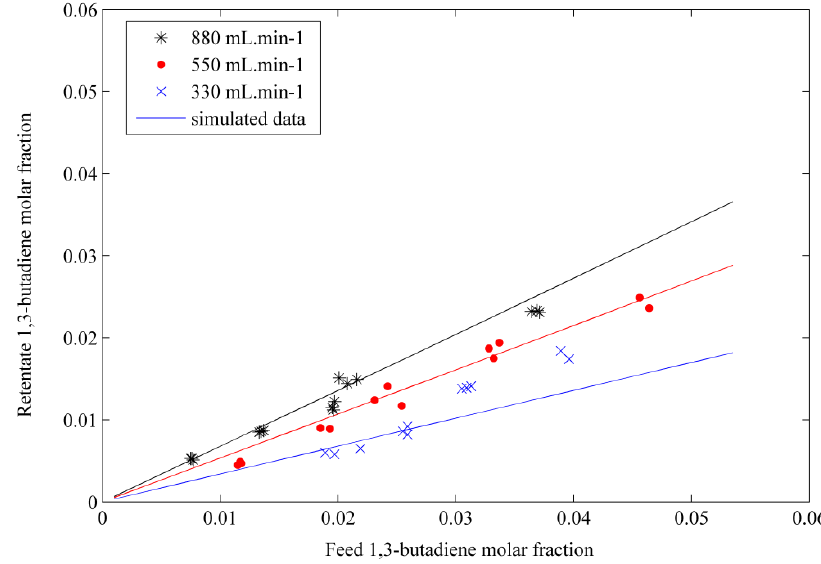
Figure 5. Variation of 1,3-butadiene molar fraction in retentate as a function of its molar fraction in feed at three different flow rates. The symbols represent the experimental data; the straight lines correspond to the simulation